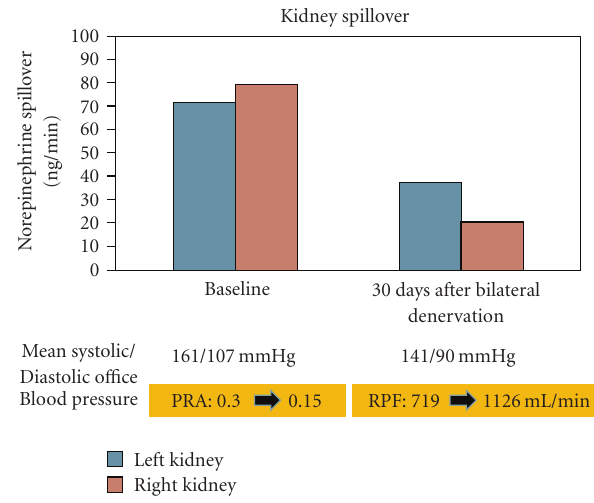
Figure 7: Blood pressure response following bilateral renal sympa- thetic denervation using a radiofrequency ablation catheter.